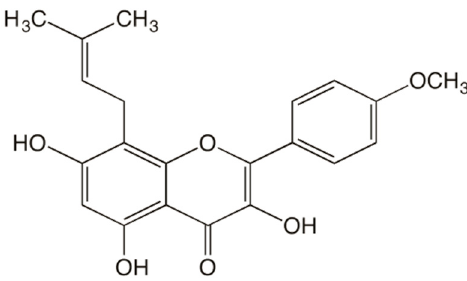
Figure 1. The structural formula of icaritin.